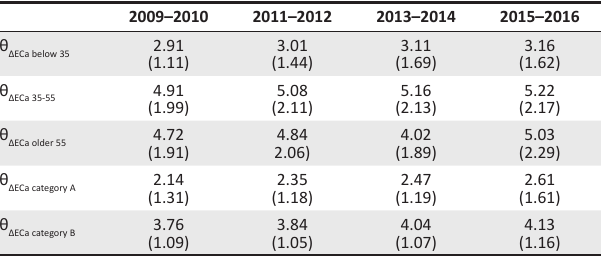
FIGURE 8: Summary of panel data estimations: Change in employee physical control.